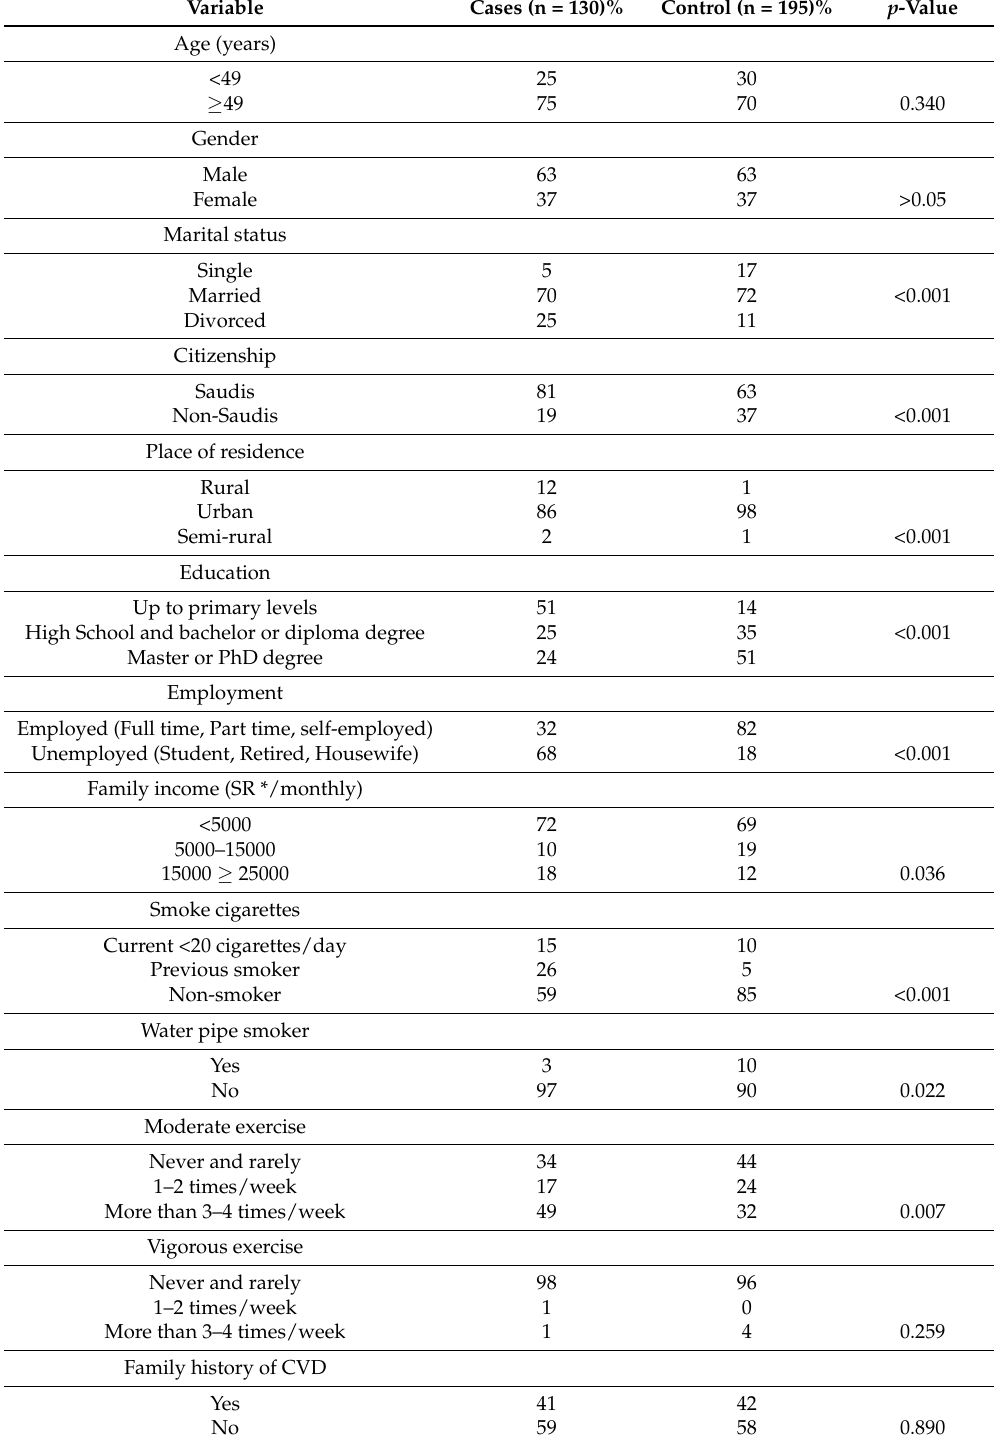
Table 1. Socio-Demographic, Family History of CVD, and Lifestyle Behaviors Characteristics of Case and Control